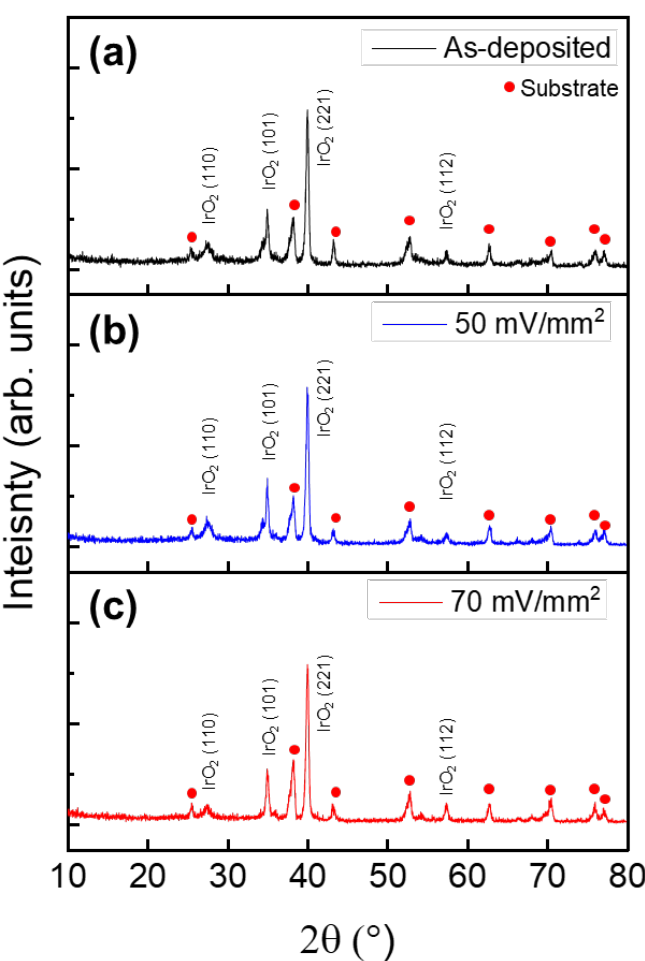
Figure 6. XRD patterns of ( a ) as-deposited, and after ED process at ( b ) 50 mV/mm 2 and ( c ) 70 mV/mm 2 . Even 70 mV/mm 2 shows parts of delamination (Figure 5d), it does not show significant difference in XRD patterns (ED processing time: 140 s, SSC thickness: 1 mm).